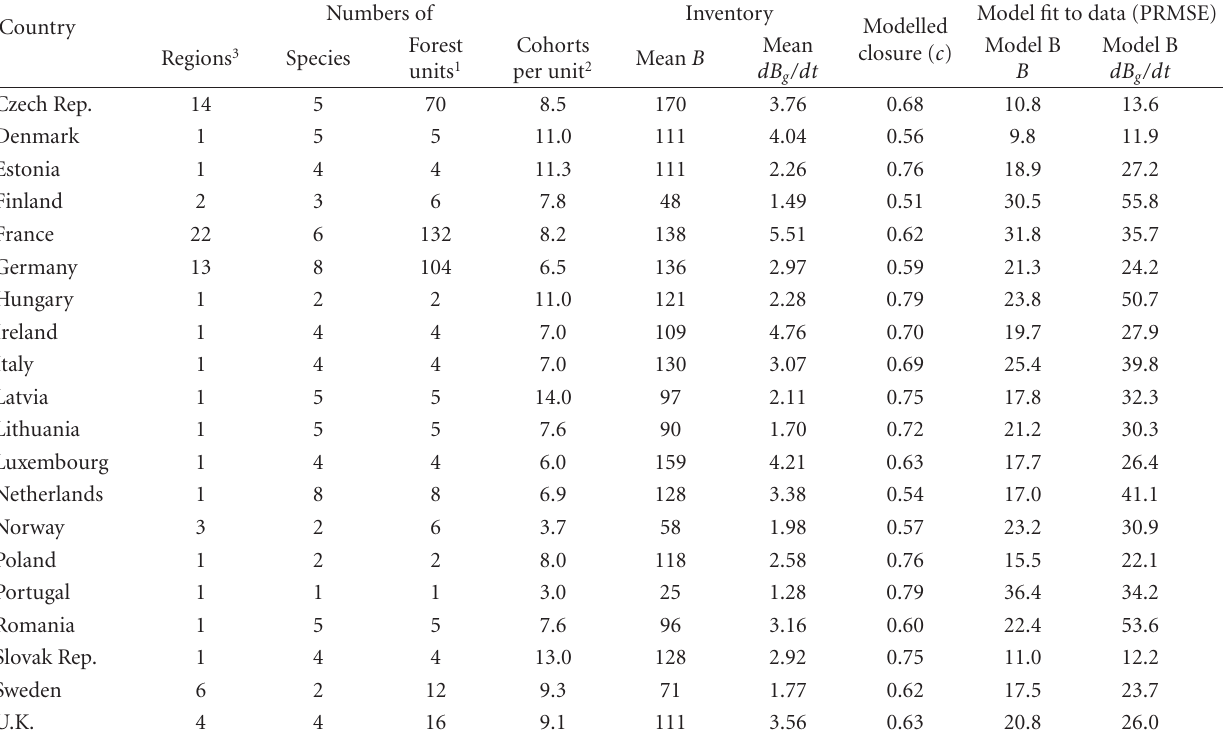
Table 3: Summary of inventory data, estimated mean closure ( c ), and large-scale model agreement with data for the countries. Symbols and units in Table